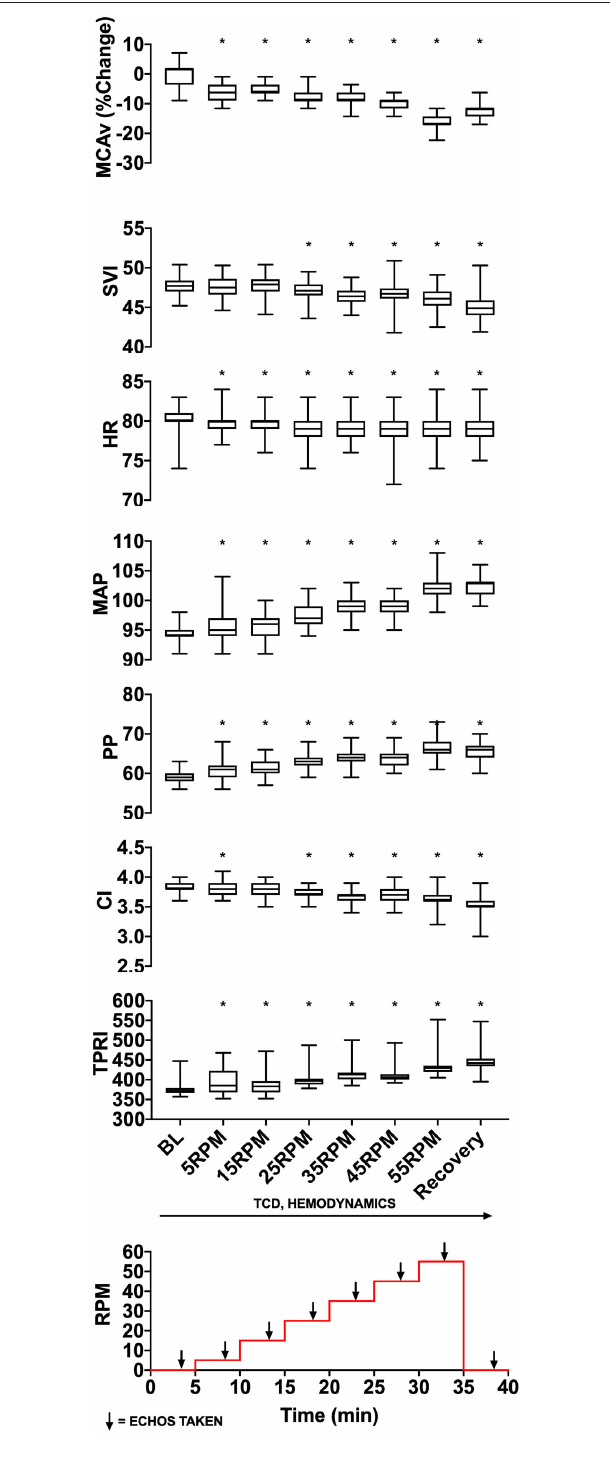
FIGURE 2 | Experimental data from a representative patient showing changes in MCAv (percentage change from baseline, cm/s), SVI (mL/m 2 /beat), HR (beats per minute), MAP (mmHg), PP (mmHg), CI (L/min/m 2 ), and TPRI (mmHg /m 2 L min) with increasing cycling cadence. The bottom panel illustrates the experimental protocol with eight 5-min stages starting from 0